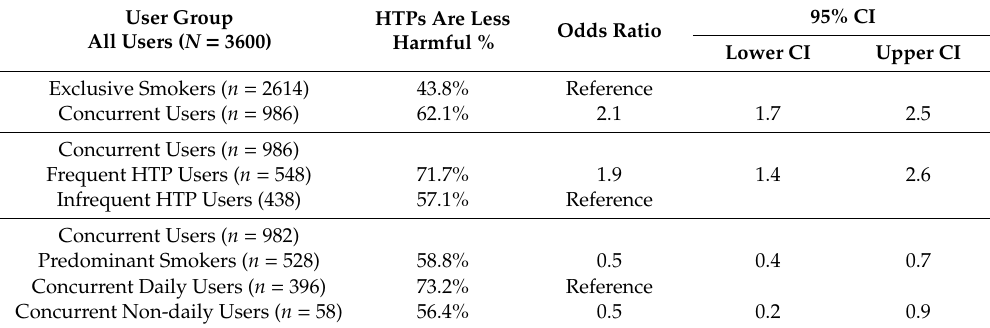
Table 2. Adjusted (Weighted) regression models estimating the odds of believing that HTPs are less harmful than cigarettes among smokers in Japan in 2018.